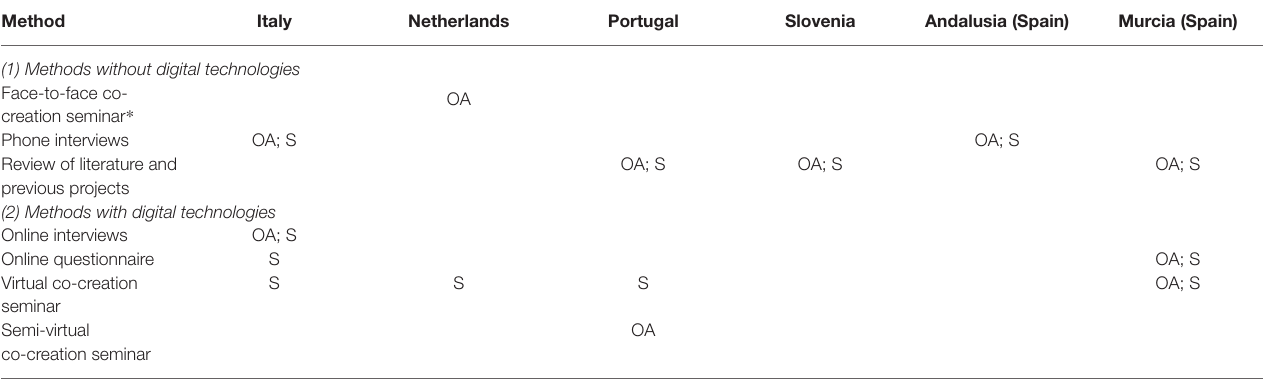
TABLE 1 | Requirements elicitation methods used for older adults and other stakeholders by pilot sites.